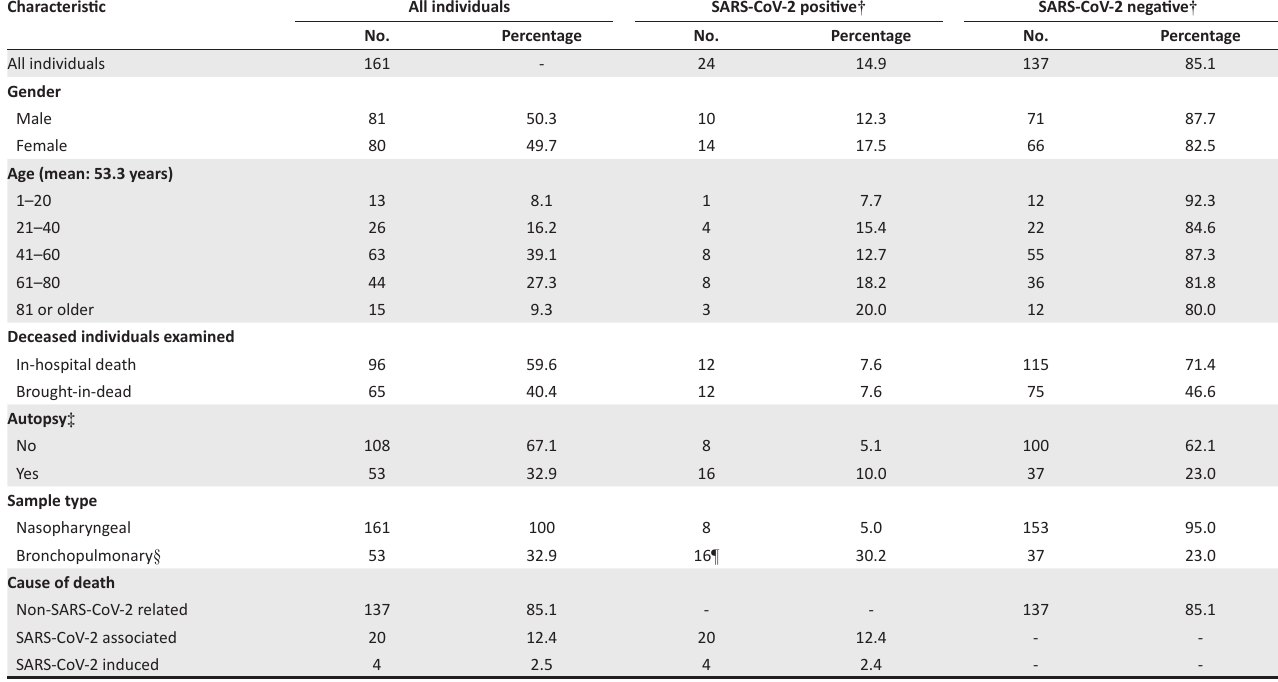
TABLE 1: Characteristics of deceased individuals examined for SARS-CoV-2 infection, 37 Military Hospital, Accra, Ghana, 4–27 May 2020. Characteristic